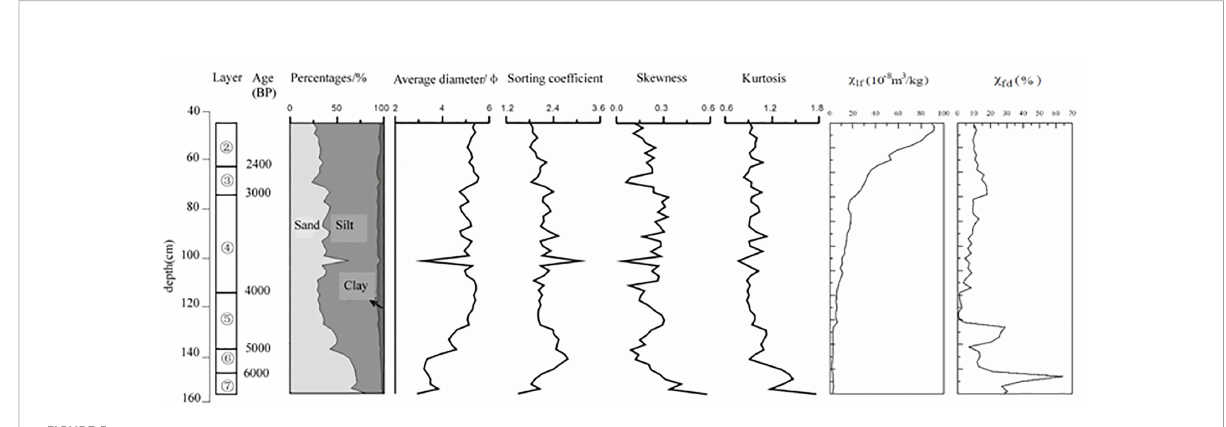
FIGURE 5 Grain size and magnetic susceptibility of the FTG